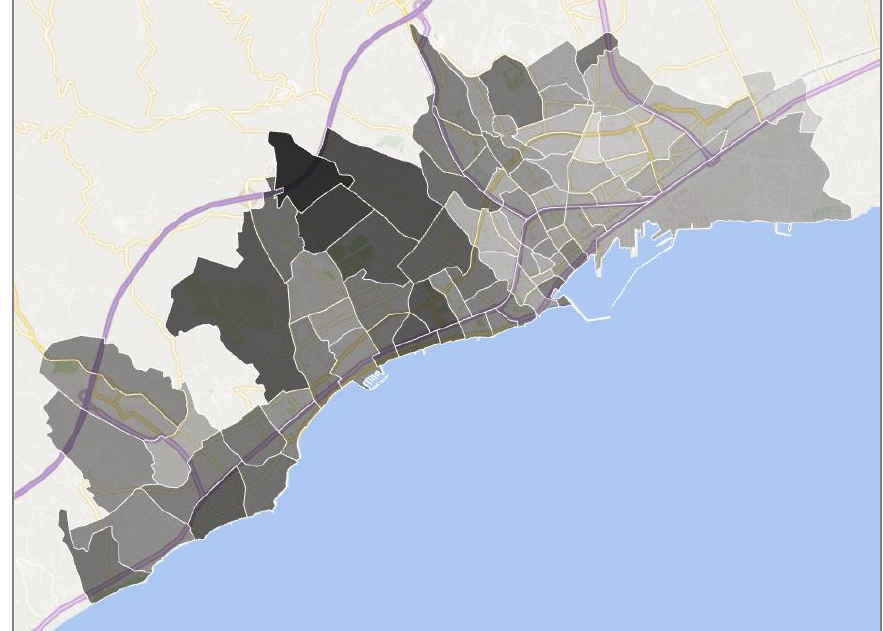
Figure 3 Automobile ownership rates by neighborhood Source: Adapted from Mersin Transport Master